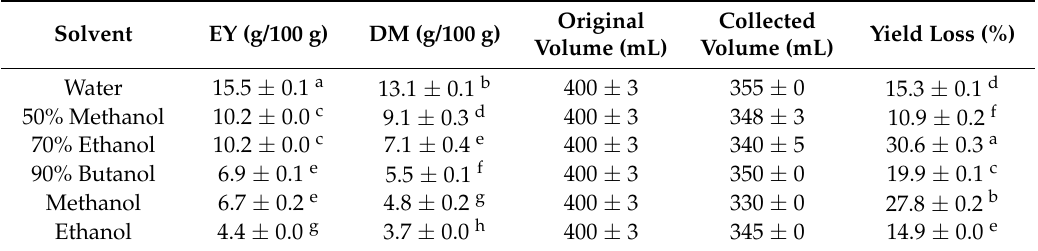
Table 2. Effect of solvent on the extractable yield (EY) and the dry mass yield